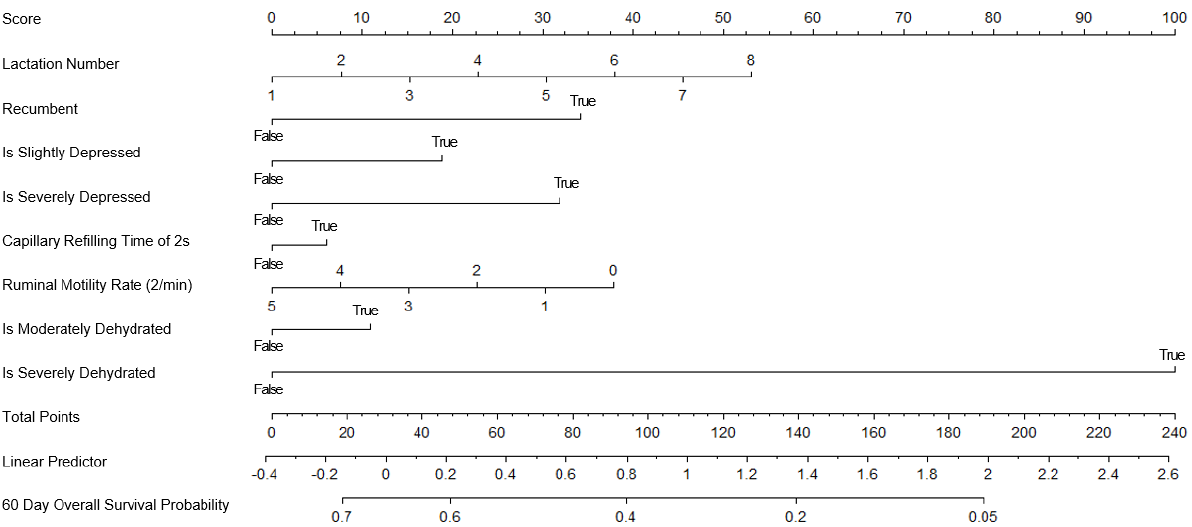
Figure 5. Nomogram predicting the 60-day survival probability of dairy cows coming from 124 herds in Québec, Canada and affected by severe clinical mastitis.